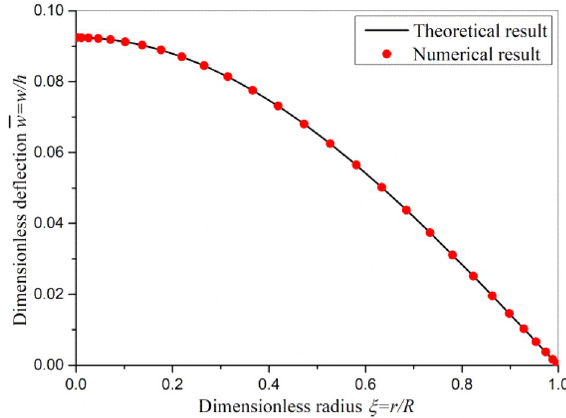
Figure 2. The bending deflection with q = 1 μN/μm 2 and V 0 = 100